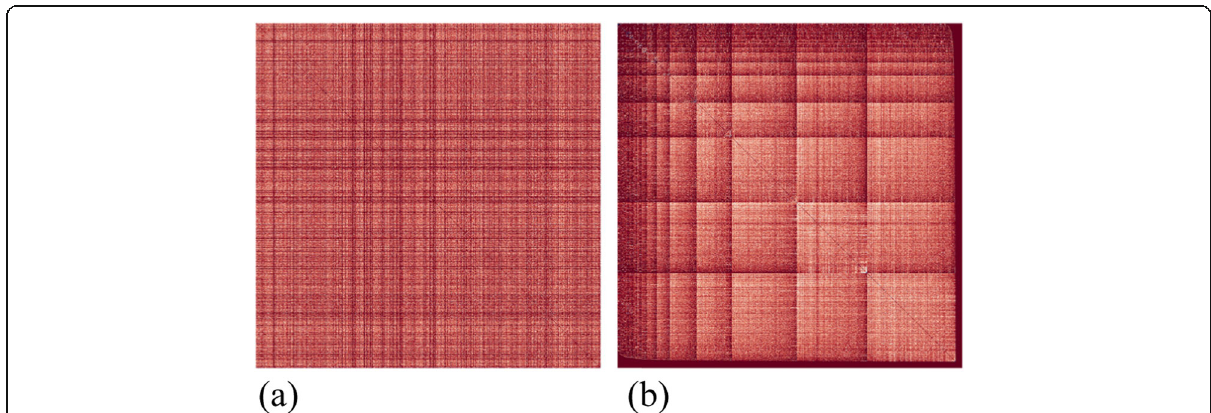
Fig. 12 a : The adjacency matrix of the initial author-similarity dataset with 1053 nodes and 907164 edges; b : The reordered dataset using the reverse Cuthill-McKee algorithm [16]